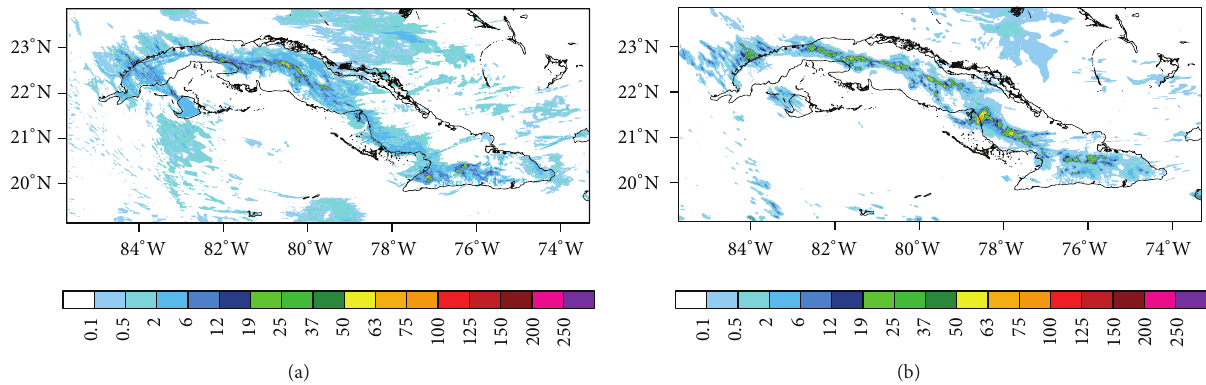
Figure 9: One-hour cumulative precipitation (mm) valid for 2100 UTC, 1 May 2012. (a) KF WSM5 experiment; (b) GF Thompson